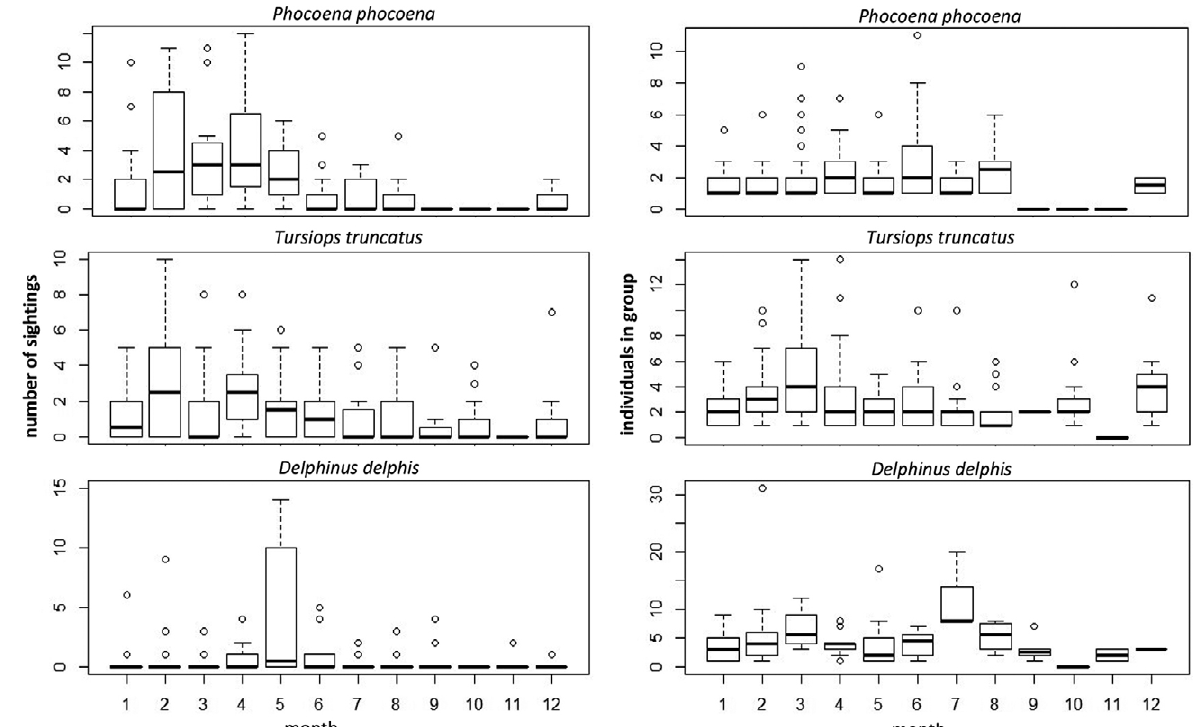
Fig. 2. – Monthly numbers of sightings and group size of the three cetacean species in the study area from January 2018 to May 2020 (the bold line within boxes indicates the